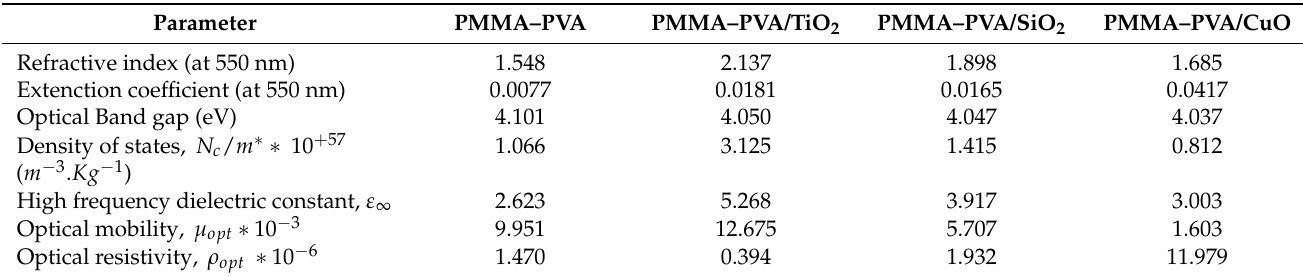
Table 3. A comparison of key essential optical and optoelectronic parameters of PMMA–PVA doped with 16% wt. of TiO 2 , SiO 2 , and CuO